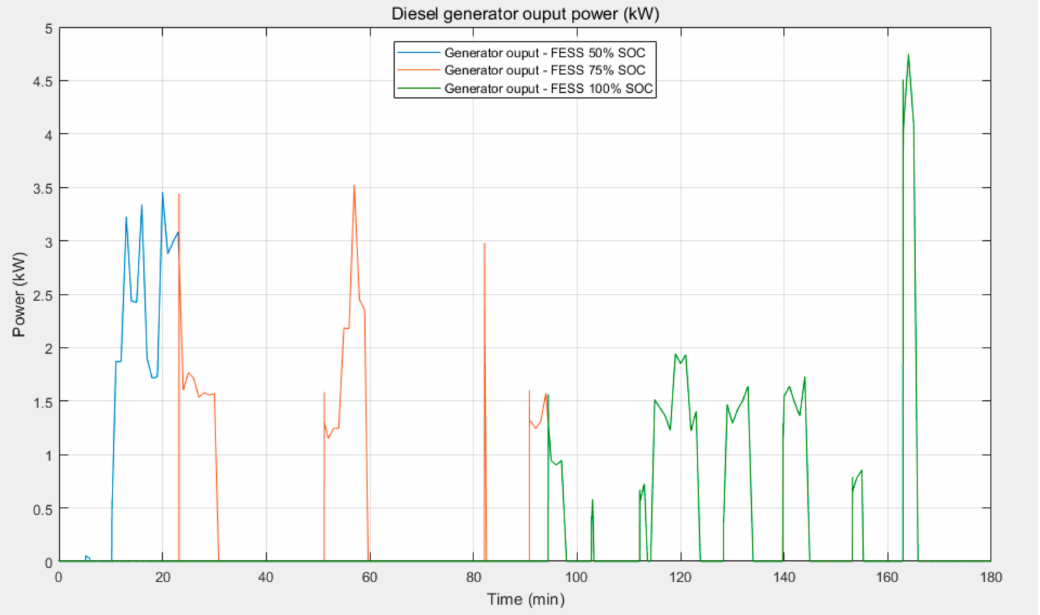
Figure 22. Generator output power based on the initial state of charge of the flywheel